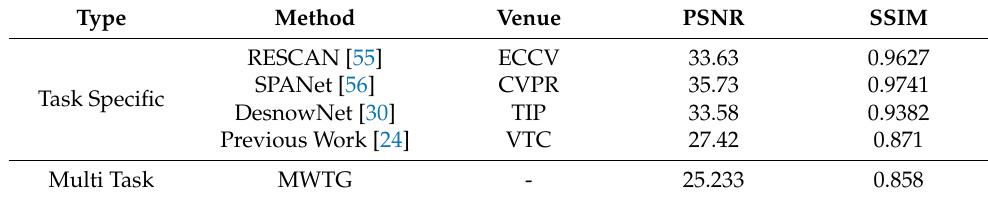
Table 3. Comparison of results with Snow